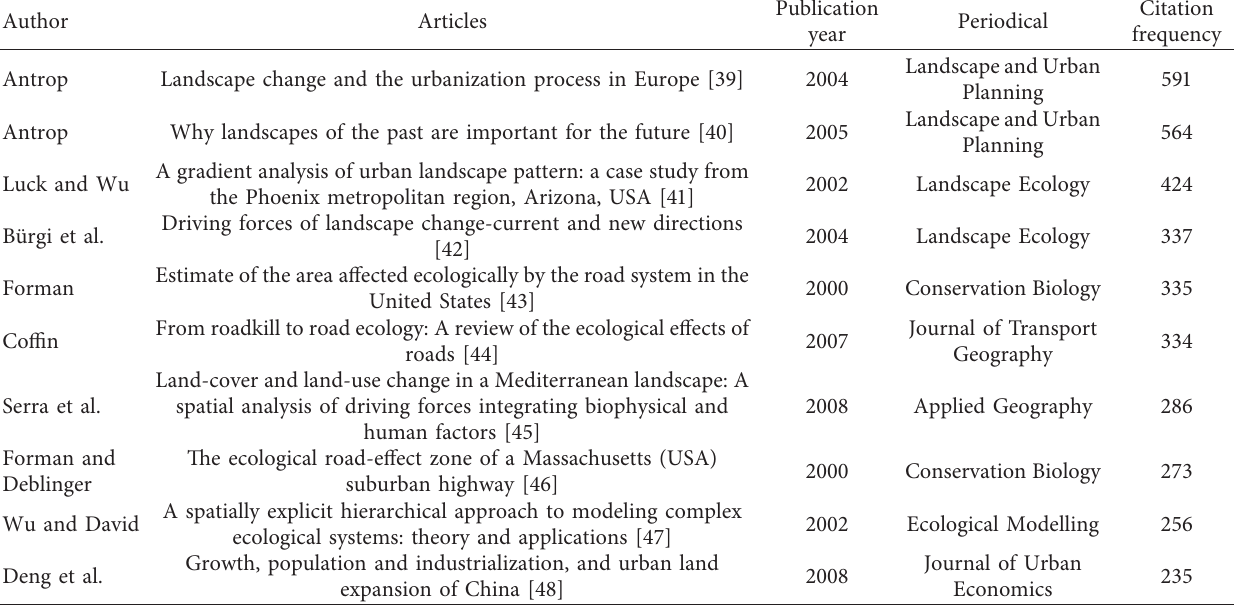
Table 1: Statistics on highly cited articles